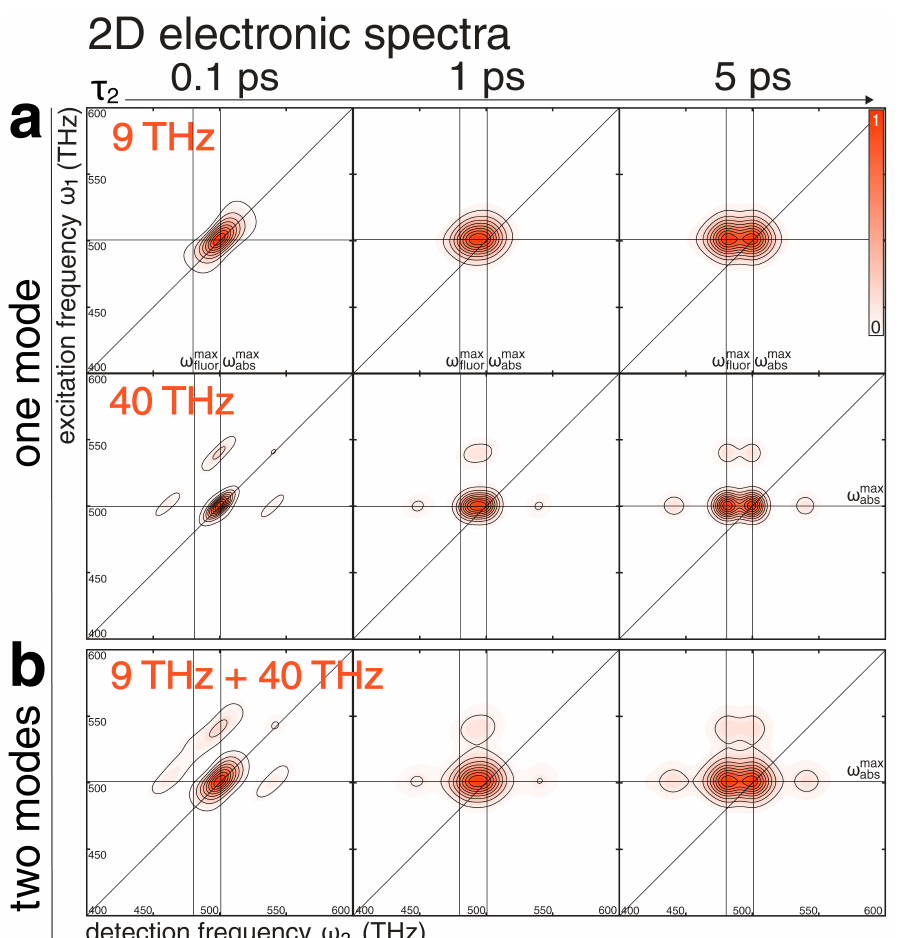
Figure 3. 2D electronic spectra shown at τ 2 time points of 0.1 ps, 1 ps, and 5 ps from simulations of ( a ) one mode with frequency ω 0 = 9 THz or 40 THz and ( b ) two modes with frequencies ω 0 = 9 THz + 40 THz. The horizontal line indicates the frequency of maximum absorption ( ω max ), abs and the vertical lines indicate both the frequency of maximum absorption ( ω max ) and the frequency of abs maximum fluorescence ( ω max ). The diagonal line indicates where ω 1 = ω 3 , or excitation frequency is fluor equivalent to detection (or emission)